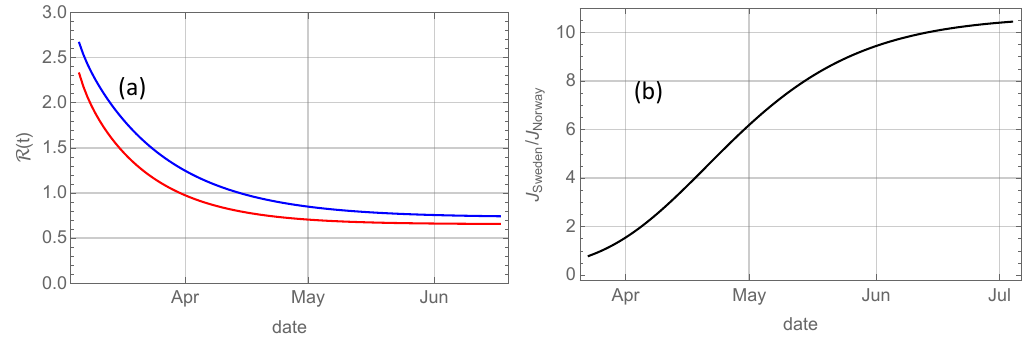
Figure 4. ( a ): Evolution of R ( t ) computed numerically from Equation (12) for Norway (red) and for Sweden (blue). ( b ): Evolution of ratio between accumulated deaths in Sweden and Norway.